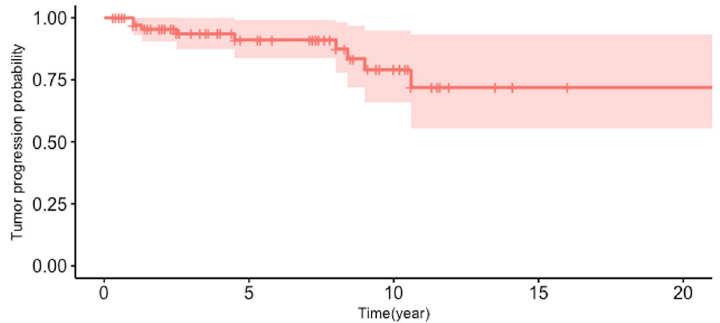
Figure 1. Kaplan–Meier survival curve analysis after GKRS for trigeminal schwannomas.